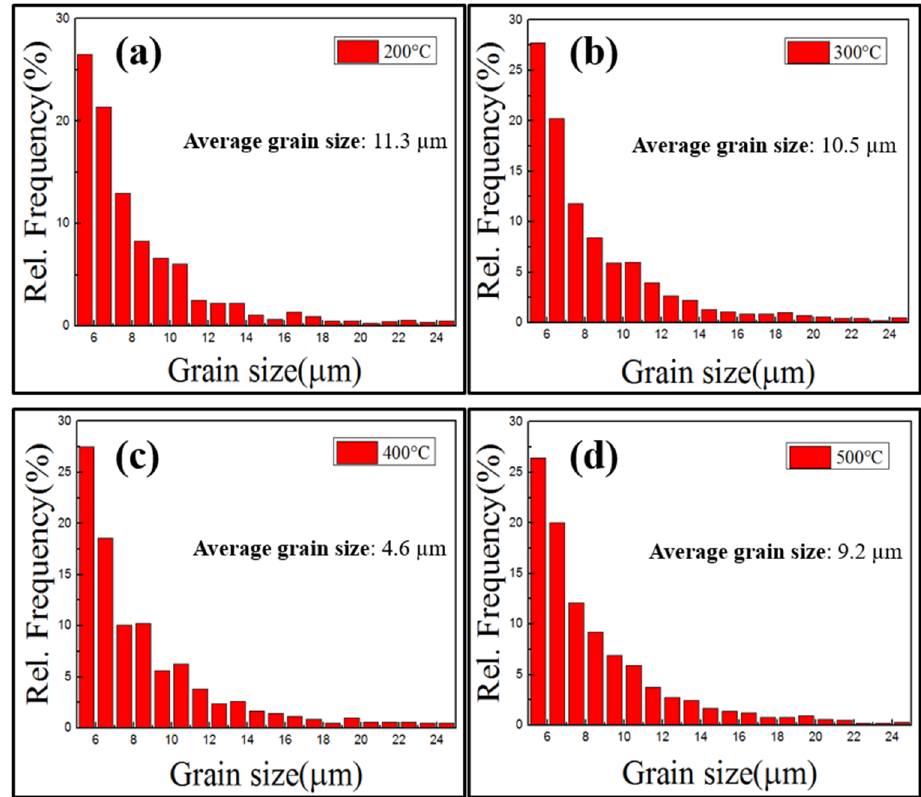
Figure 5. Maps showing grain size distribution at different temperatures: ( a ) 200 °C, ( b ) 300 °C, ( c ) 400 °C, and ( d ) 500 °C.